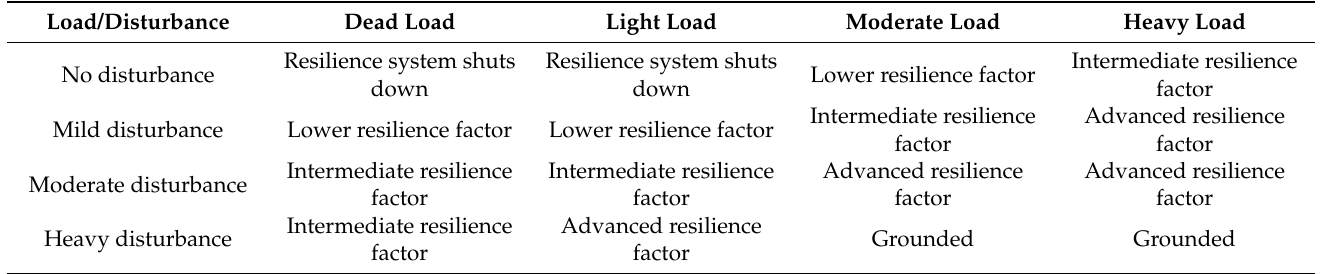
Table 3. Schematic representation of the degree of adjustment of the resilience